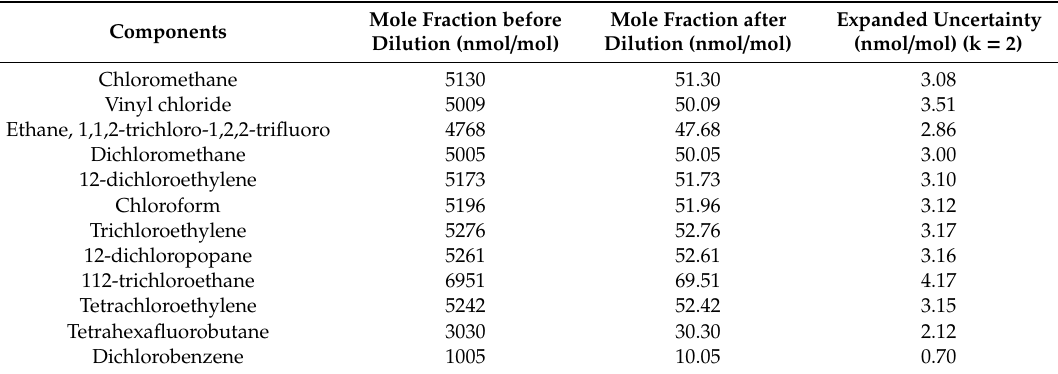
Table 2. Composition of the gas mixture used for halogenated hydrocarbons.